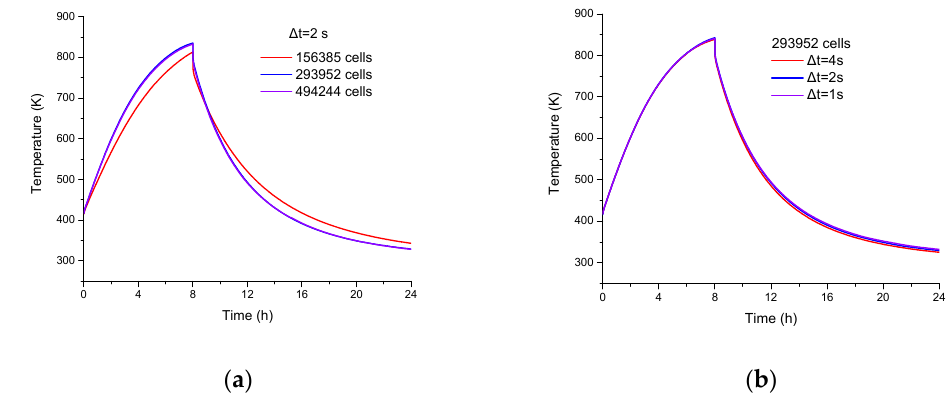
Figure 2. The evolution of the air temperature at the outlet with different grids ( a ) and different time steps ( b ).